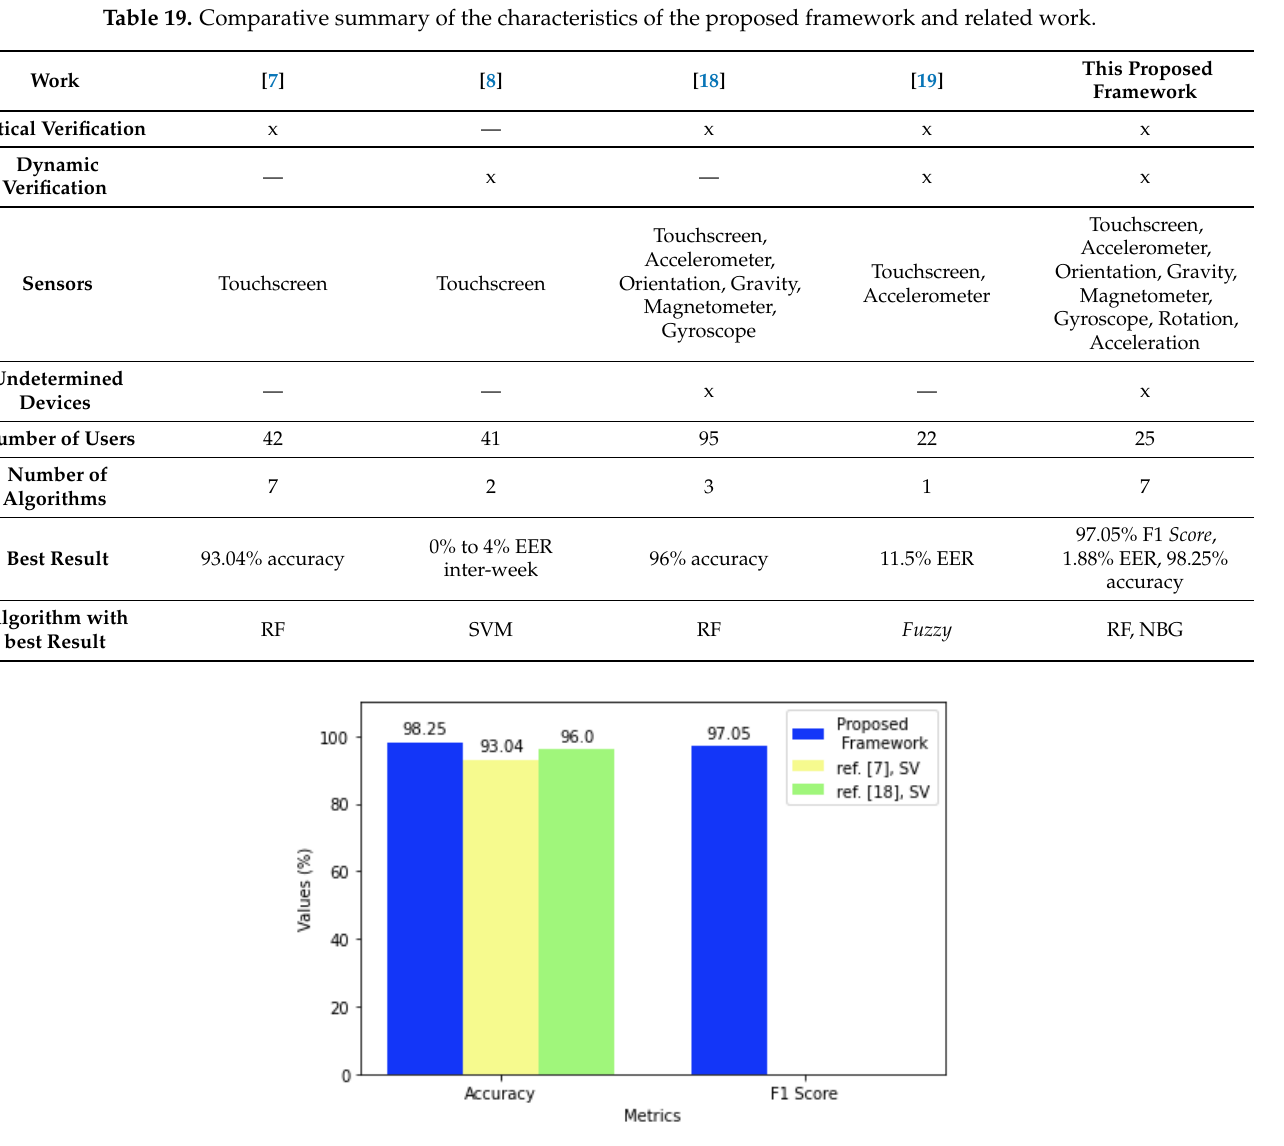
Figure 6. Performance comparison of the proposed framework with the best results from the reviewed literature for AC and